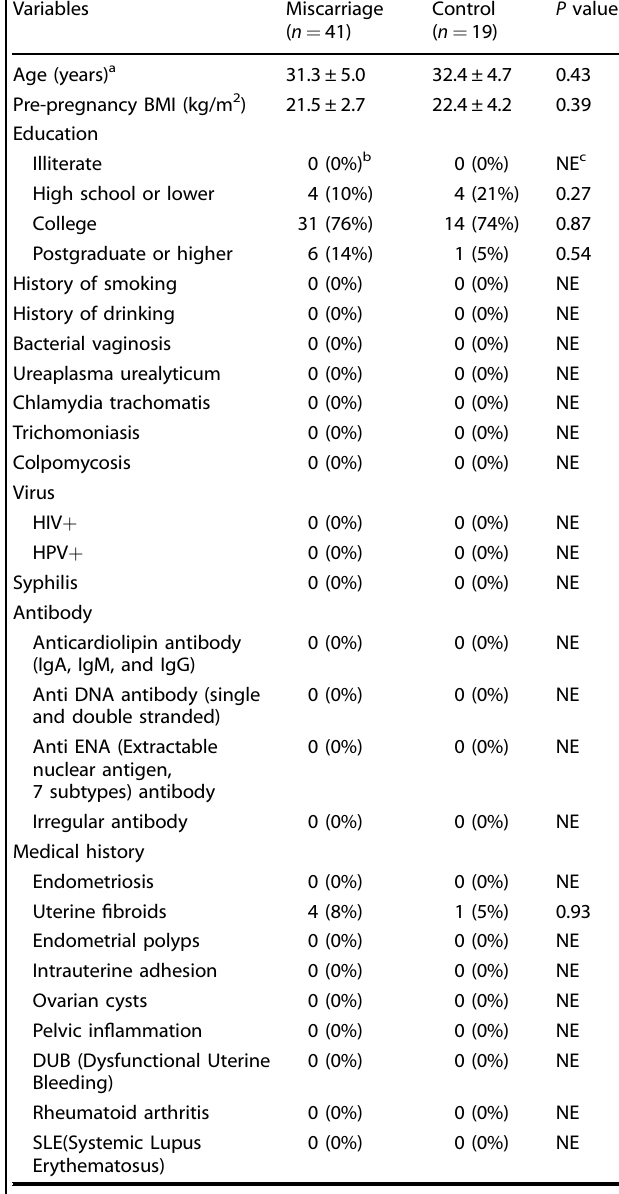
Table 1. Demographic and clinical characteristics of women with miscarriage and the